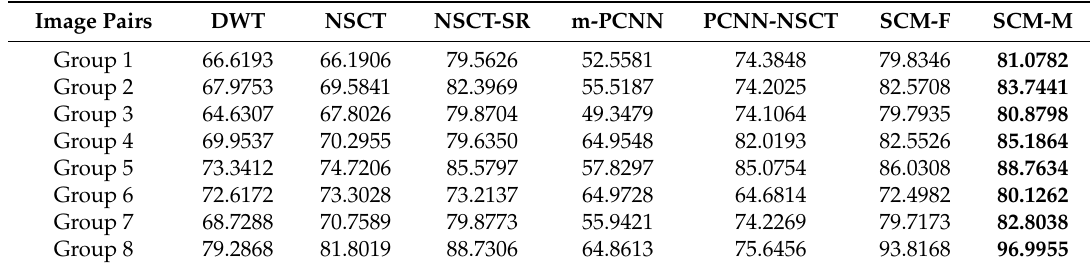
Table 6. STD for the seven methods operating on the eight groups of medical